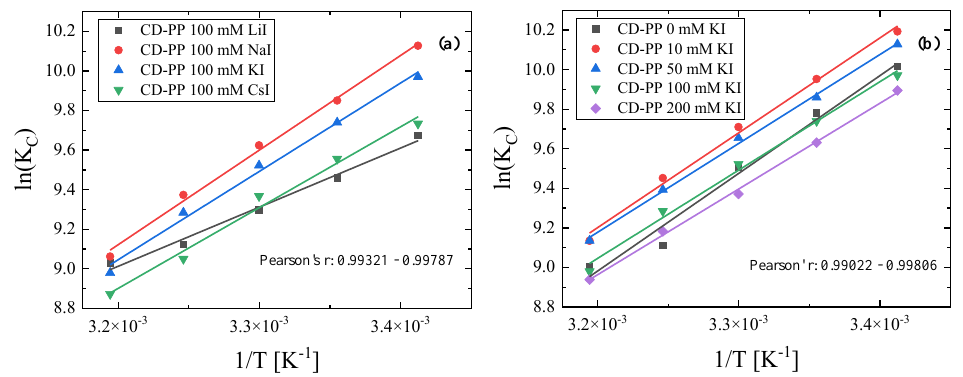
Figure 4. Plots of lnKc as a function of reciprocal temperature 1/T for different alkali-types (a) and salt concentrations (b). Pearson’s parameters reveal an almost perfect linear dependency. Table 1. The complexation coefficient and the thermodynamic parameters ∆ H, ∆ G, and ∆ S for the β -cyclodextrin – phenolphthalein complex formation.